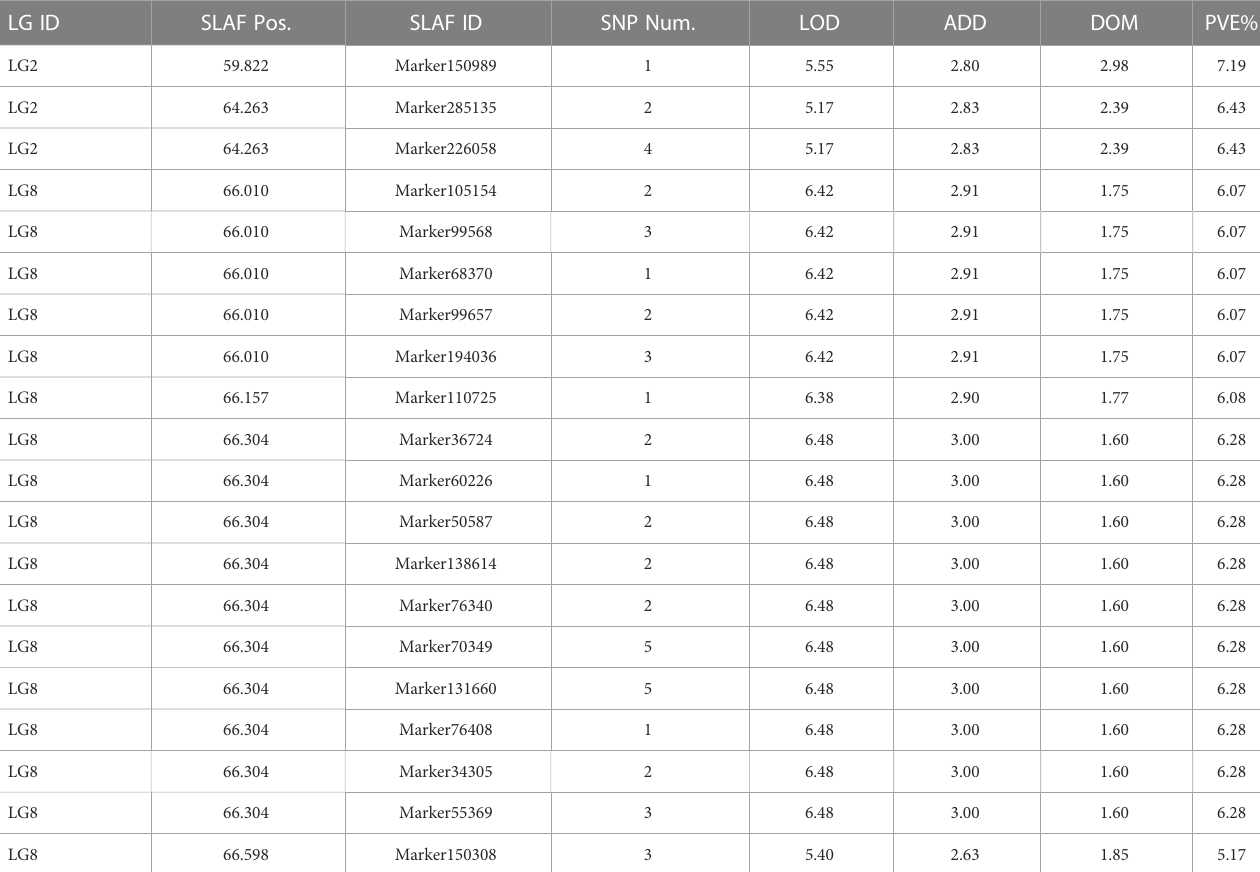
TABLE 5 Detailed information of effective favorable allelic variant SLAF markers for the fl ower stalk height. LG ID SLAF Pos. SNP